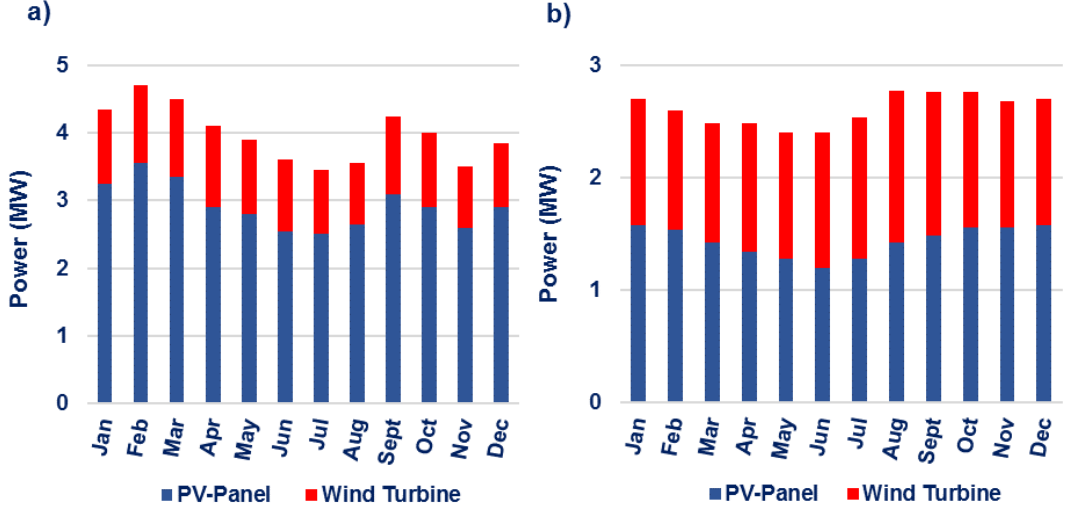
Figure 8. Contribution of renewable energy sources to the monthly average electricity production of the hybrid power system for scenario A: ( a ) Case-Kenya and ( b ) Case-South Africa.